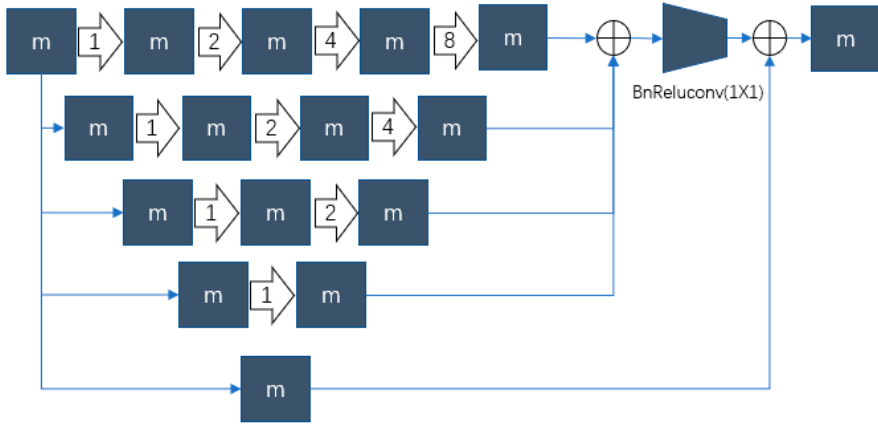
Figure 7. The construction of d-blockplus.